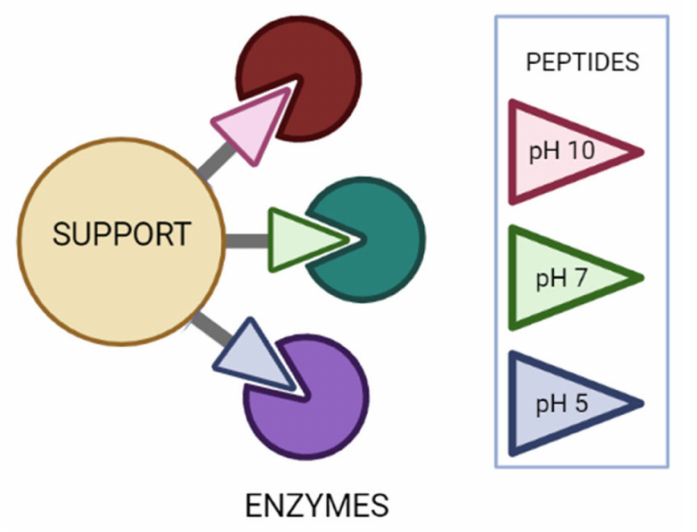
Figure 9. Peptide-guided bonds where different enzymes are immobilized on the same support that has regions with different